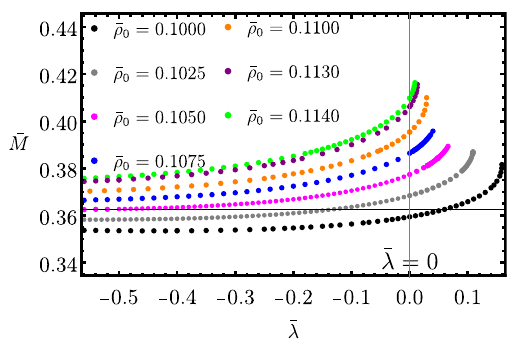
Fig. 4 ¯ M as a function of ¯ λ , for different values of ¯ ρ